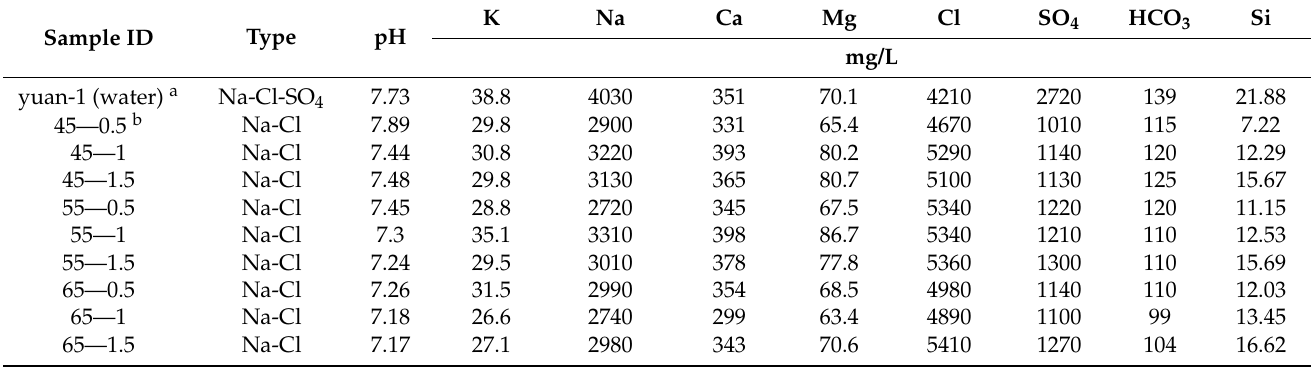
Table 3. Contents of major elements in water before and after displacement experiments. a Referenced in [45]; b 45—05 denotes 45 ◦ C and 0.5 mL/min